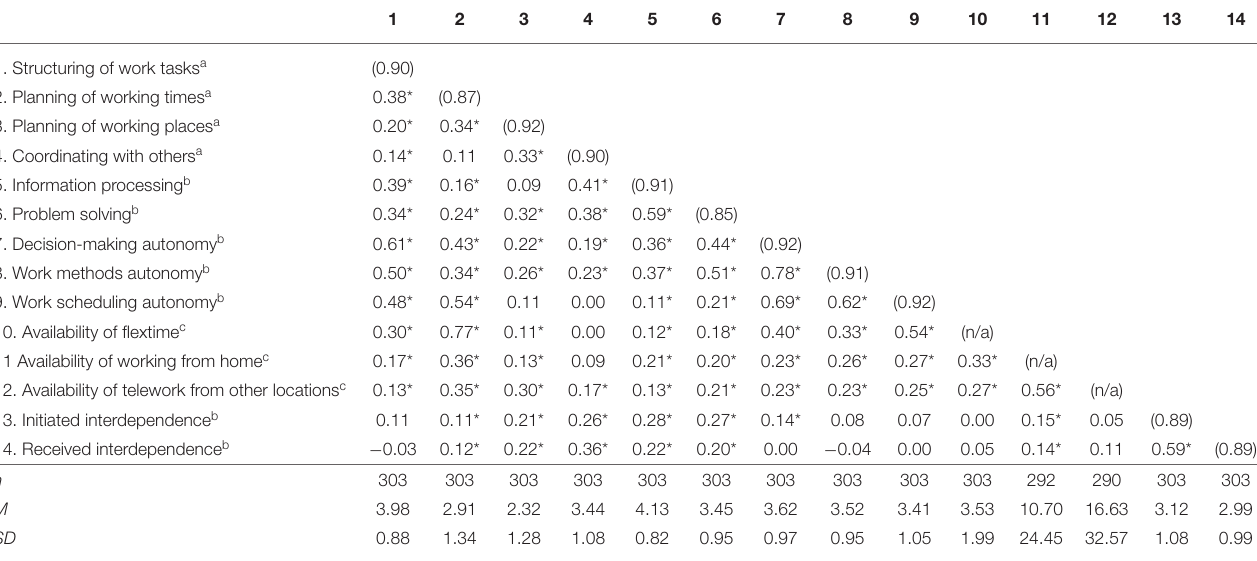
TABLE 1 | Descriptive statistics, Cronbach’s alphas, and correlations for study 1.